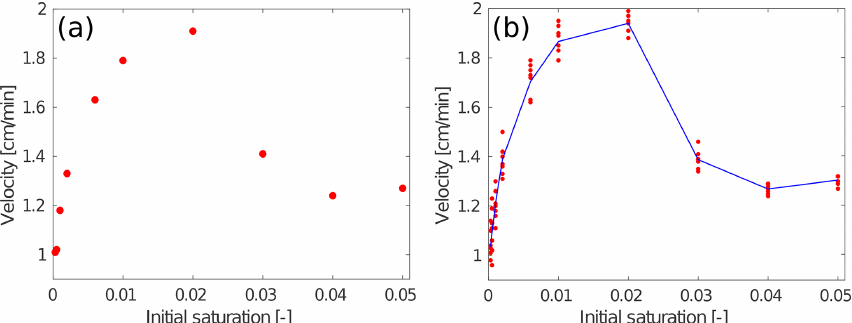
Figure 6. The velocity of the wetting front at t = 25min is plotted against the initial saturation. (a) The distribution of the intrinsic perme- ability given by Fig. 3. (b) All simulations given by eight different distributions of the intrinsic permeability (see Figs. 3 and A2). The blue line connects the averages.